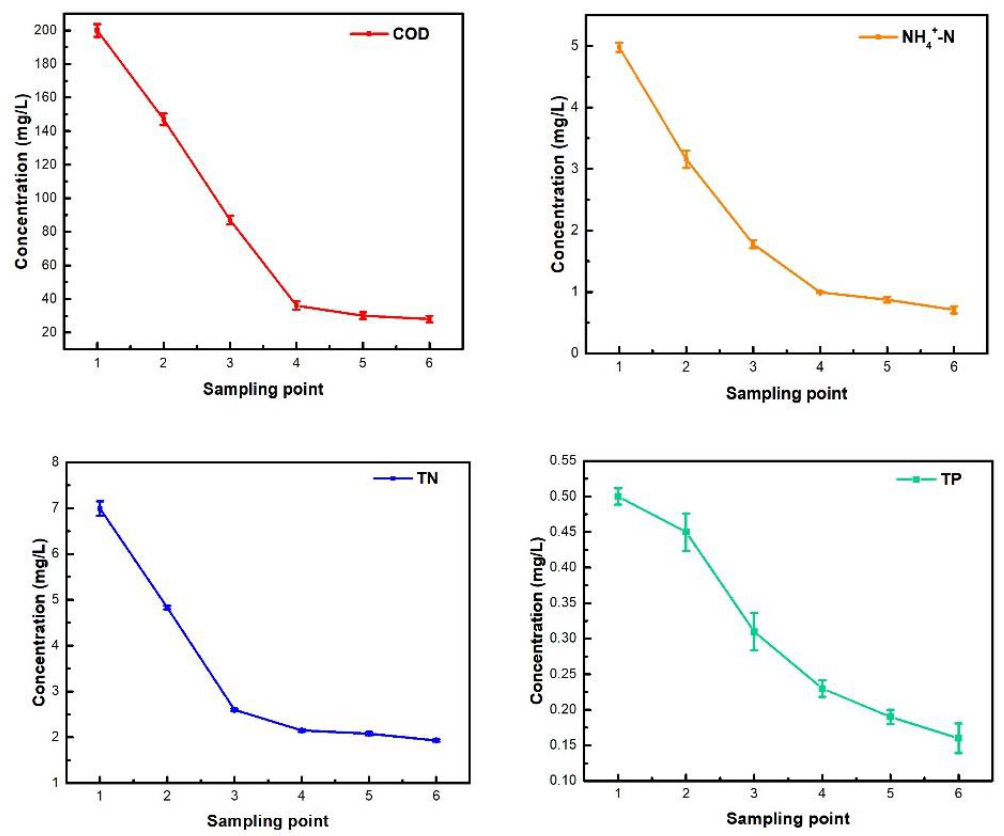
Figure 3. Concentration of COD cr , NH 4+ -N, TN, and TP from different outlets of the same bioretention system .